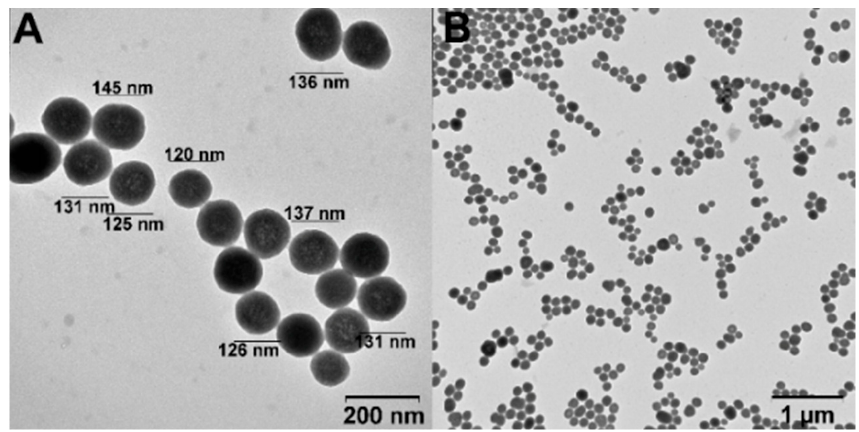
Figure 4. TEM image of SiNPs-DOX. The high ( A ) and low ( B ) magnification images.